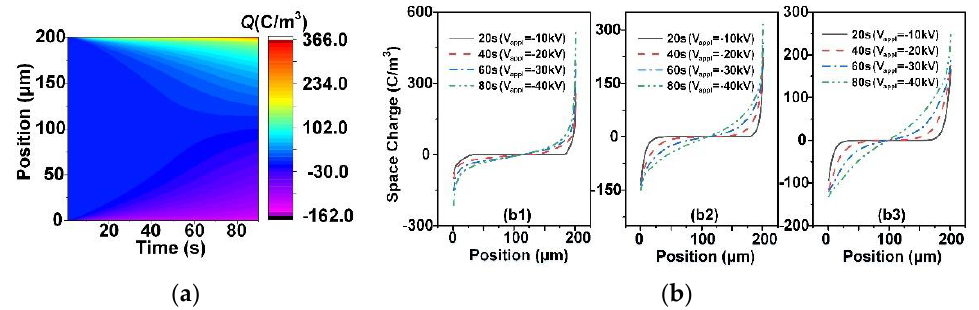
Figure 3. Space charge distribution in the sample with random orientation ( a ) and comparisons of space charge distribution as a function of time in the polymer with various orientations: parallel orientation ( b1 ) random orientation ( b2 ) perpendicular orientation ( b3 ).